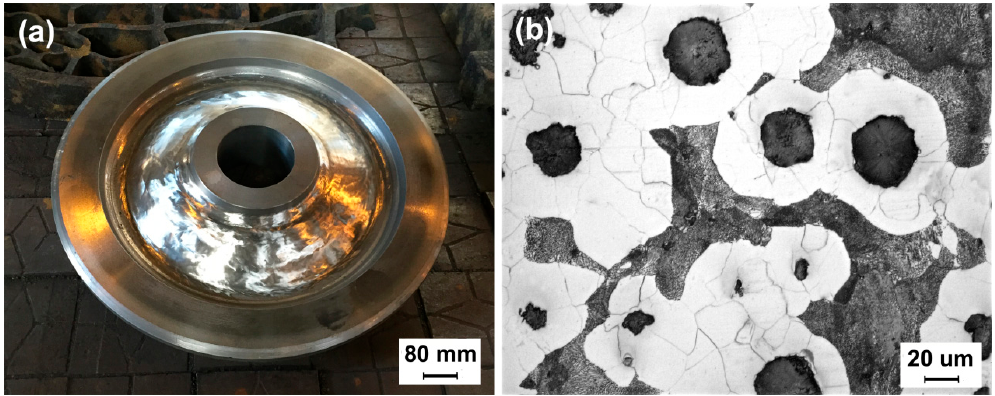
Figure 3. ( a ) Ductile iron wheel for rail-transit vehicles. ( b ) As-cast microstructure.